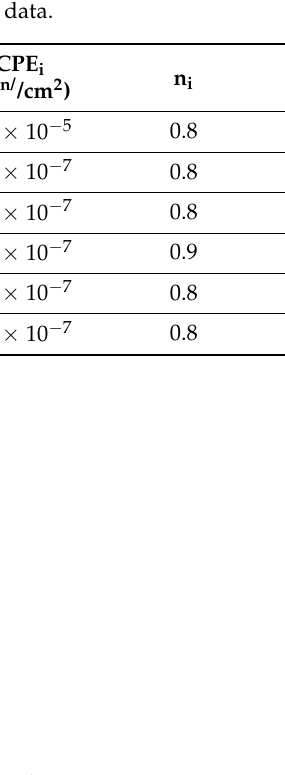
Figure 10. Equivalent electric circuit used to simulate EIS